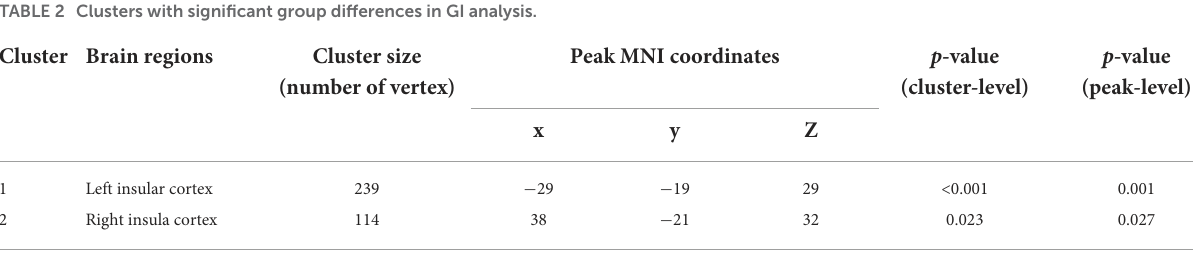
TABLE 2 Clusters with significant group differences in GI